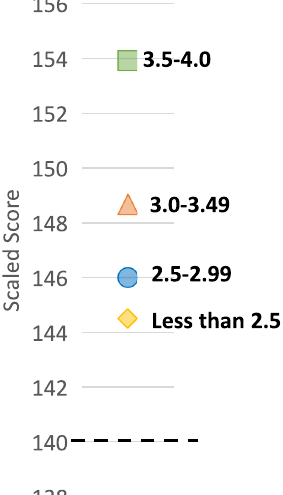
FIG. 4. Praxis physics subject assessment performance by examinees ’ reported undergraduate GPA. Scaled score is plotted on the y axis. Dashed line represents the national median passing score of 140. Source: Derived from data provided by the Educational Testing